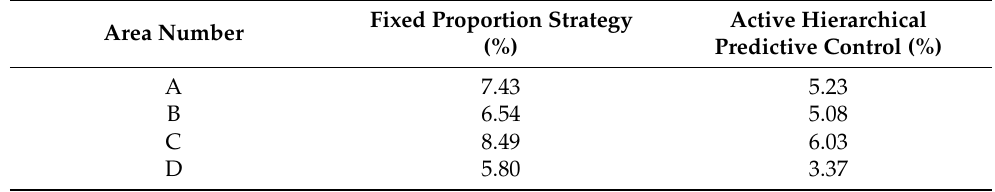
Table 6. Comparison of wind farm abandonment rates in different regions. Fixed Proportion Strategy Active Area Number (%)